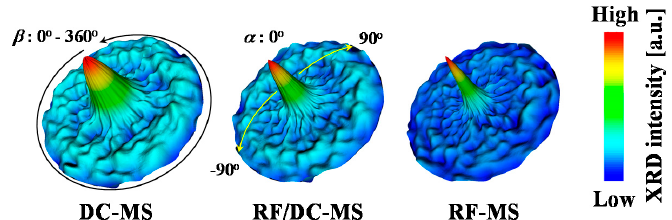
Figure 6. Three-dimensional projections of XRD pole figures of 0002 reflection of 500-nm-thick AZO films deposited by DC magnetron sputtering (DC–MS), RF/DC magnetron sputtering at a power ratio of 0.14 and by RF magnetron sputtering (RF–MS).